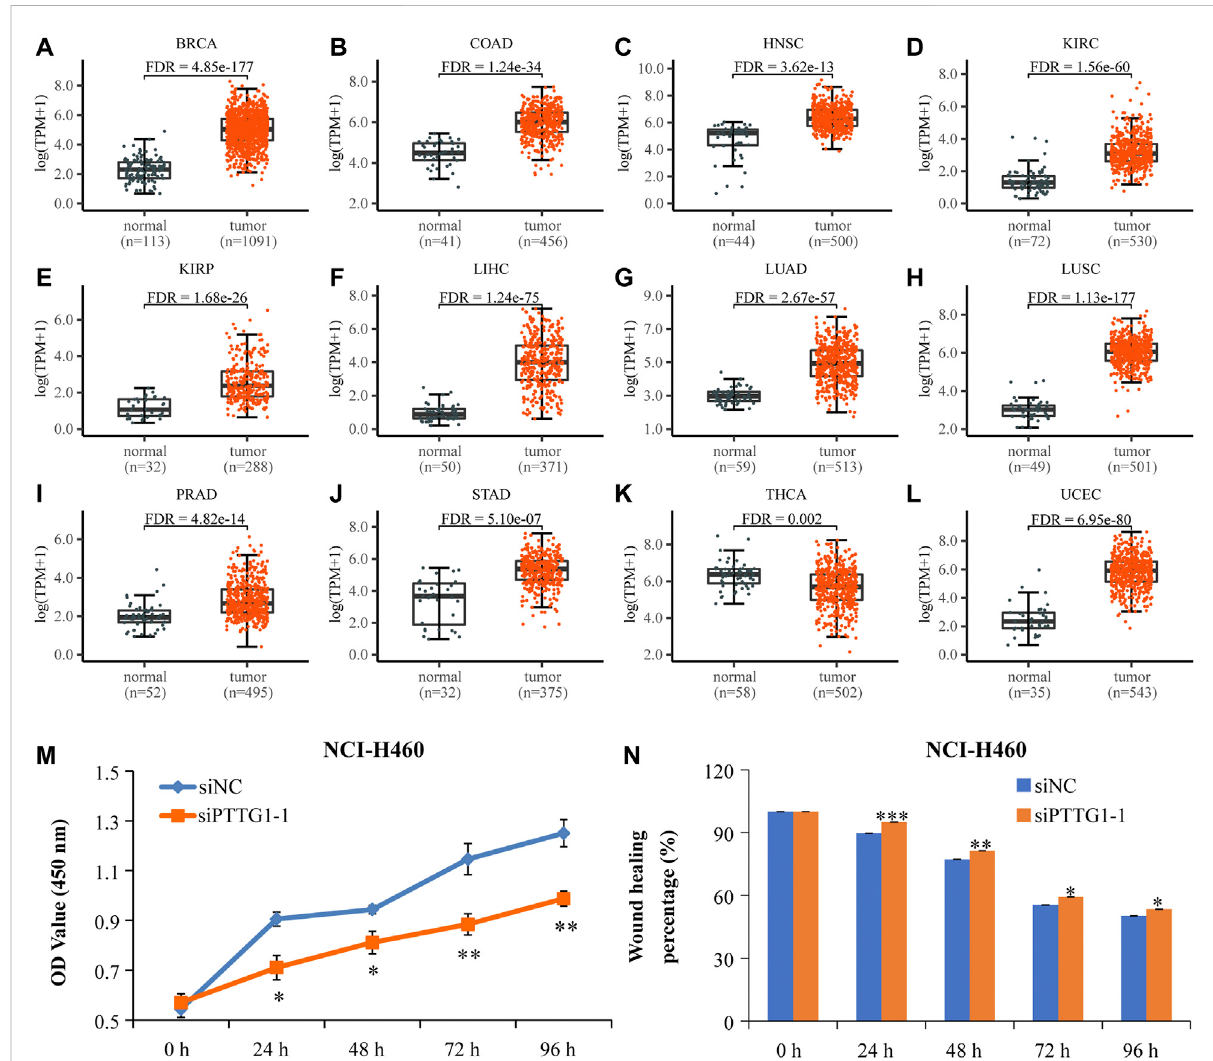
FIGURE 7 The high-expressed PTTG1 in pan-cancers and interfering PTTG1 could signi fi cantly suppress lung cancer cells ’ proliferation and migration. (A-L) Scatter plots showing the expression levels of the PTTG1 gene of normal tissues (black) and tumor tissues (red) in pan-cancer. (M) The low expression level of PTTG1 strikingly repressed NCI-H460 cell proliferation. (N) The low-expressed PTTG1 could signi fi cantly repress cell mobility